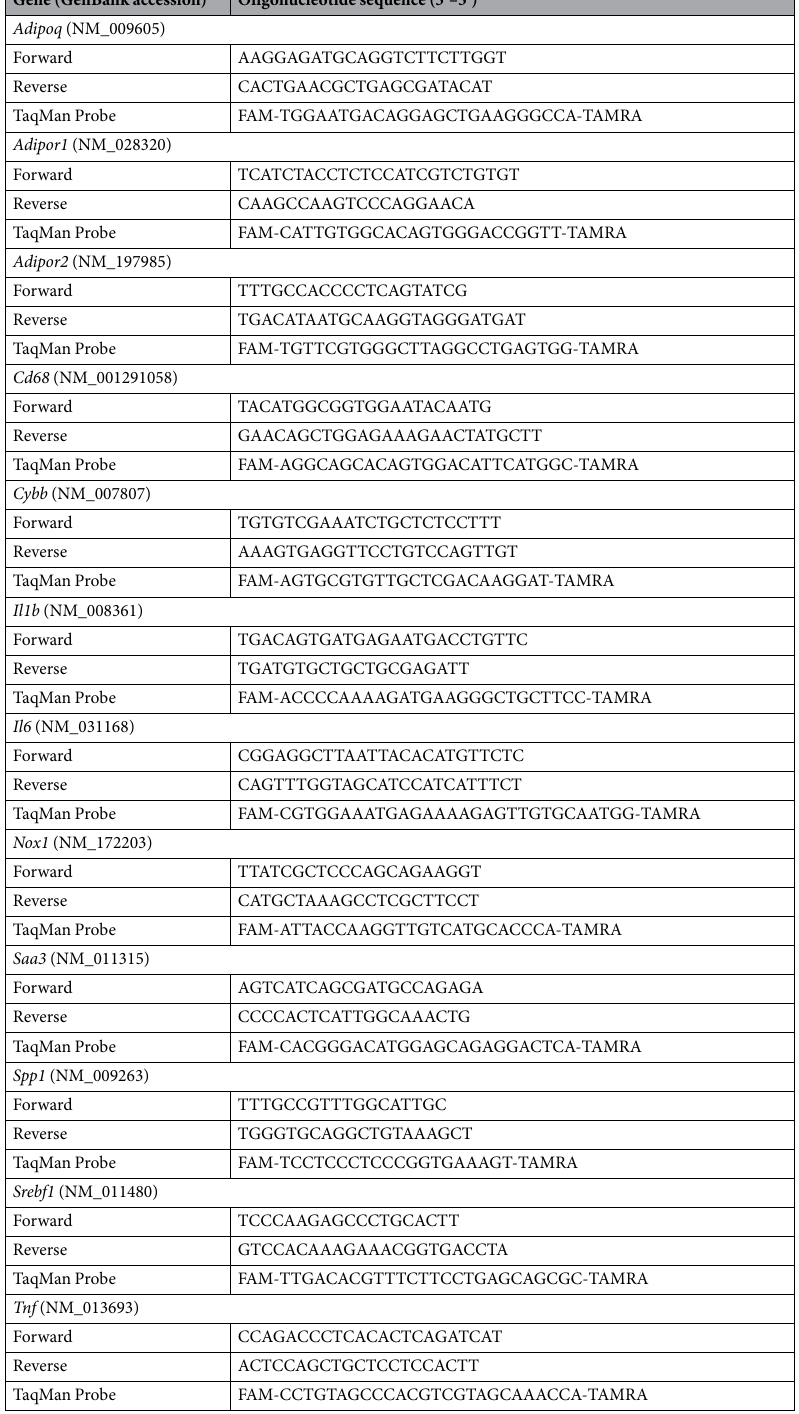
Table 2. Sequences of the primers and TaqMan probes. Adipoq , adiponectin; Adipor1 , adiponectin receptor 1; Adipor2 , adiponectin receptor 2; Cd68 , macrophage antigen CD68; Cybb , superoxide-generating NADPH oxidase heavy chain subunit (Nox2); Il1b , interleukin-1 β ; Il6 , interleukin-6; Nox1 , NADPH Oxidase 1; Saa3 , serum amyloid A3; Spp1 , secreted phosphoprotein 1 (osteopontin), Srebf1 , sterol regulatory element binding transcription factor 1; Tnf , tumor necrosis factor- α